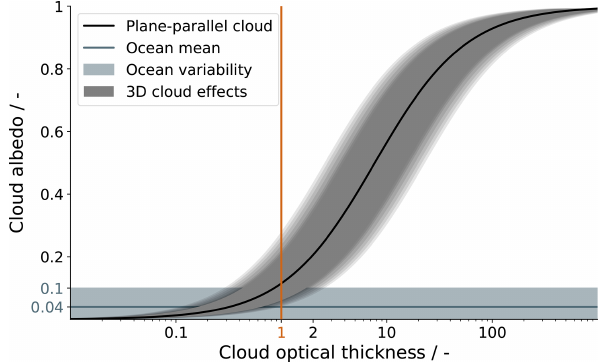
Figure 6. Plane-parallel relationship between cloud albedo and cloud optical thickness following Lacis and Hansen (1974). The ocean reflectance is estimated from the ASTER observations dur- ing EUREC 4 A, while the uncertainty due to 3D radiative effects is a rough estimate from the literature (Marshak et al., 2006; Stevens et al., 2019).